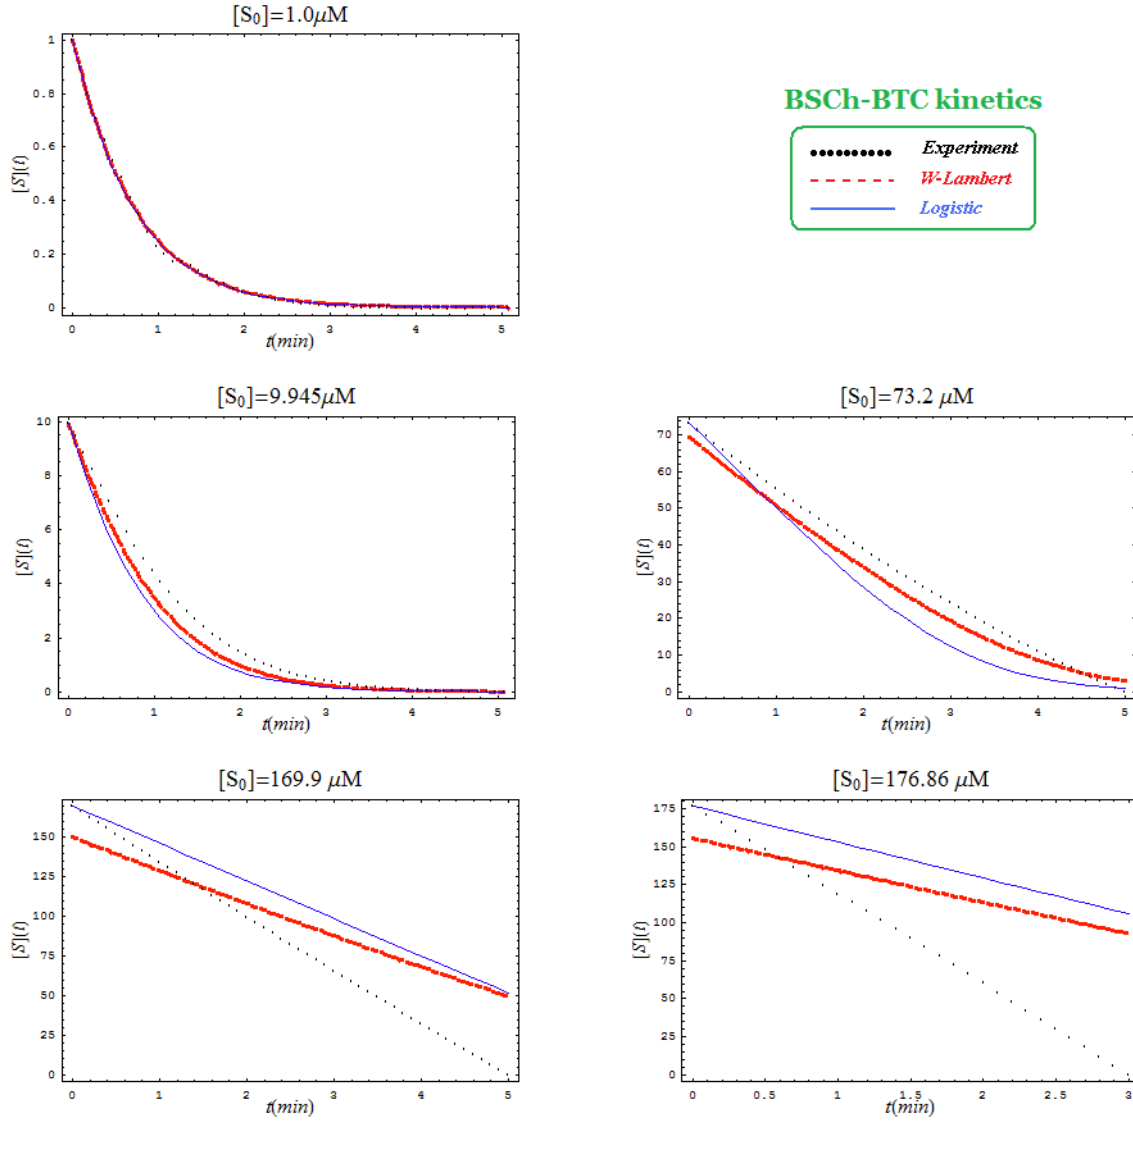
= 7.5 µM; K = 8,700 µM; S SS